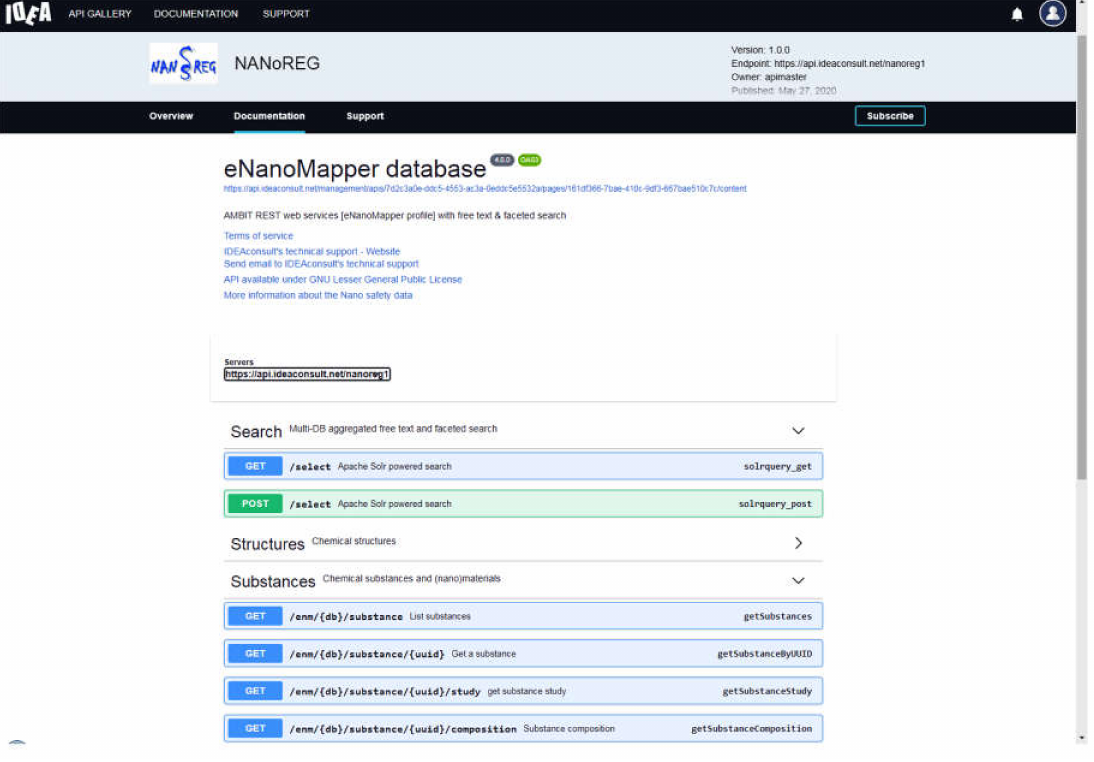
Figure 10. Interactive Application Programming Interface documentation at https: // api.ideaconsult.net /